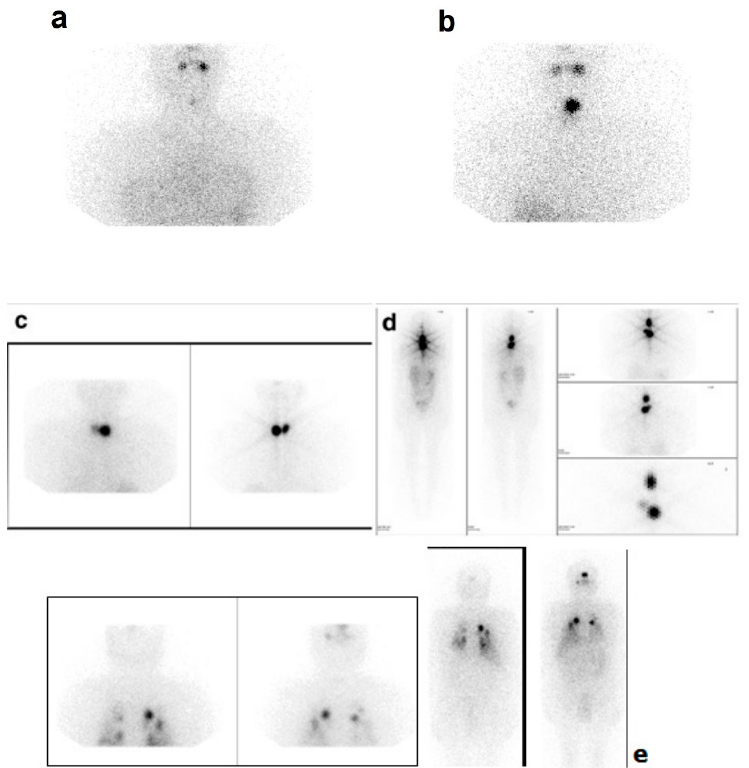
Figure 1. Representative post-ablation whole body scan (WBS) images illustrating scores for intensity of uptake and maximum remnant scores: ( a ) score 1 (low uptake), ( b ) score 2 (intermediate uptake), ( c ) score 3 (high uptake), ( d ) score 4 (star effect), ( e ) score 5 (distant metastases).